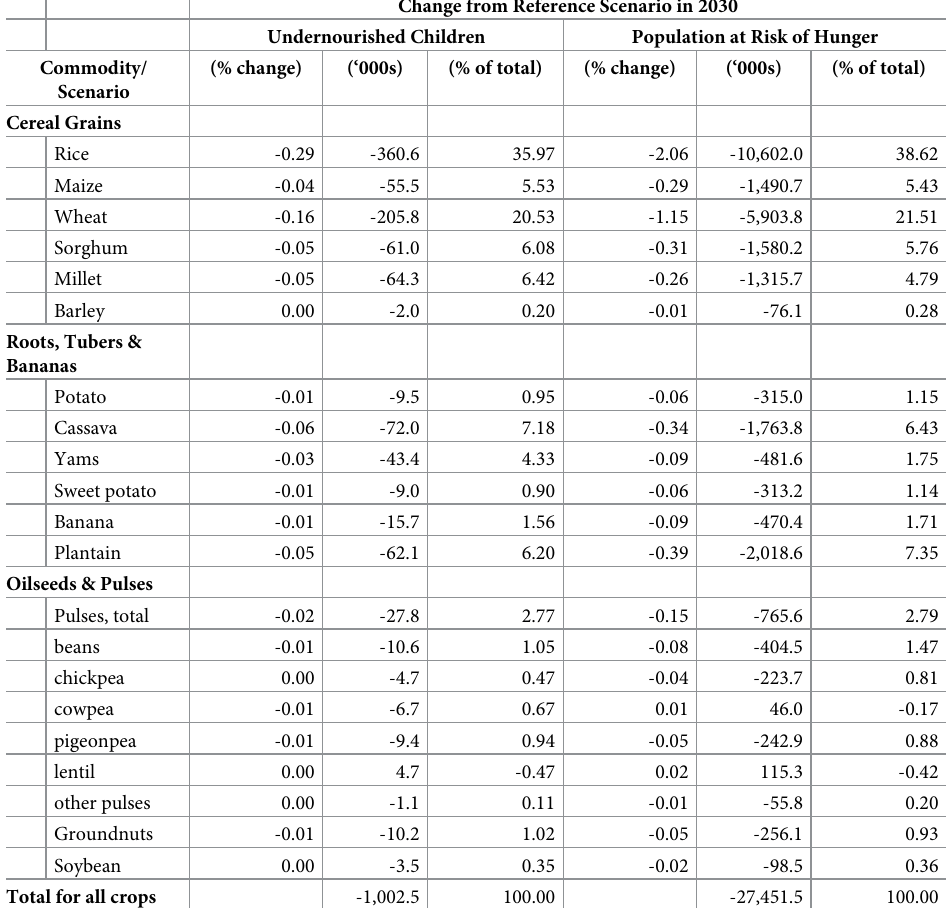
Table 9. Change in undernourished children and population at risk of hunger in 2030 from faster productivity growth. Change from Reference Scenario in